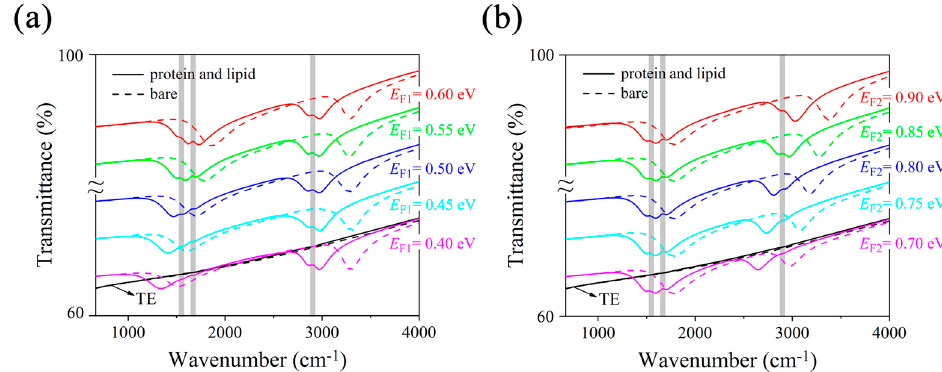
Figure 2. Transmittance spectra of MRGB under transverse electric (TE) (black curves) and transverse magnetic (TM) (colored curves) mid-infrared incidence while sweeping E F 1 ( a ) and E F 2 ( b ) of graphene, with (solid curves) and without (dashed curves) protein and lipid molecules. Gray vertical bars represent vibrational bands of protein and lipid molecules. Curve with larger E F is translated upward with 6% in order to demonstrate the spectral shift clearly.